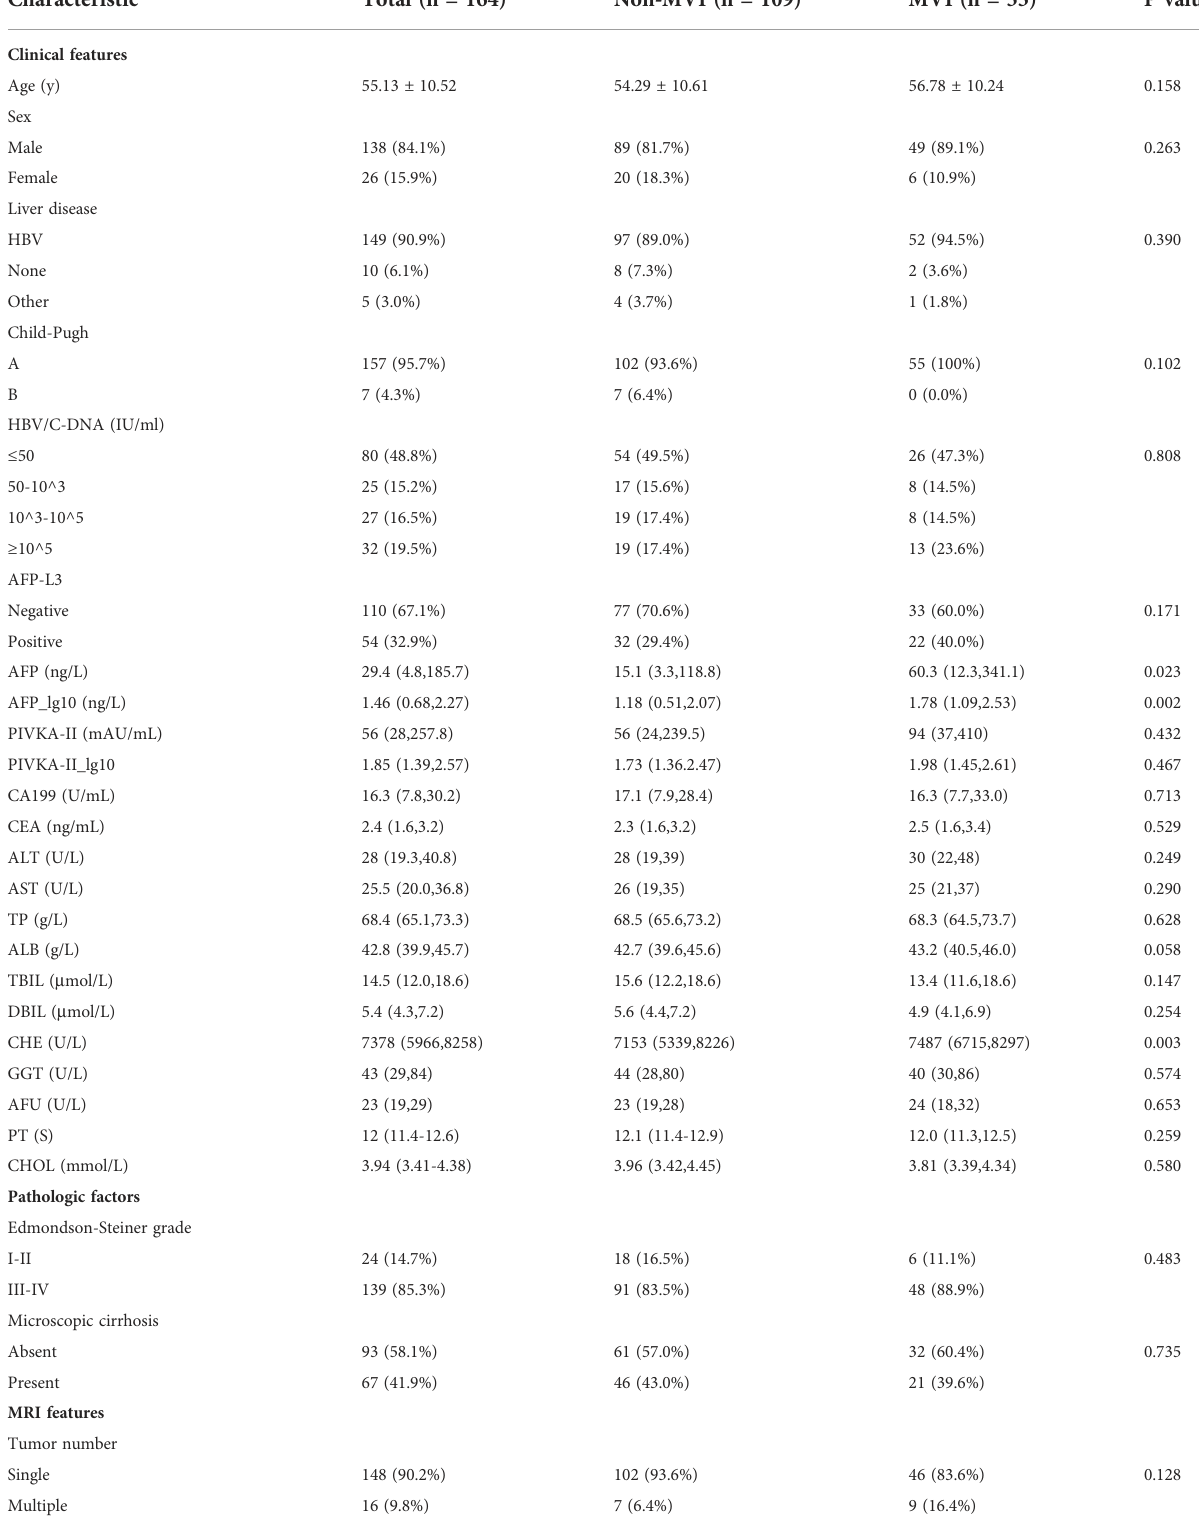
TABLE 1 Clinicoradiological characteristics for predicting